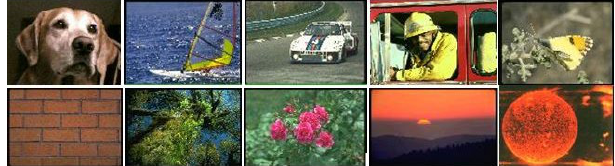
Figure 6. Sample Image of Corel-5k database Description of Corel-10K dataset :